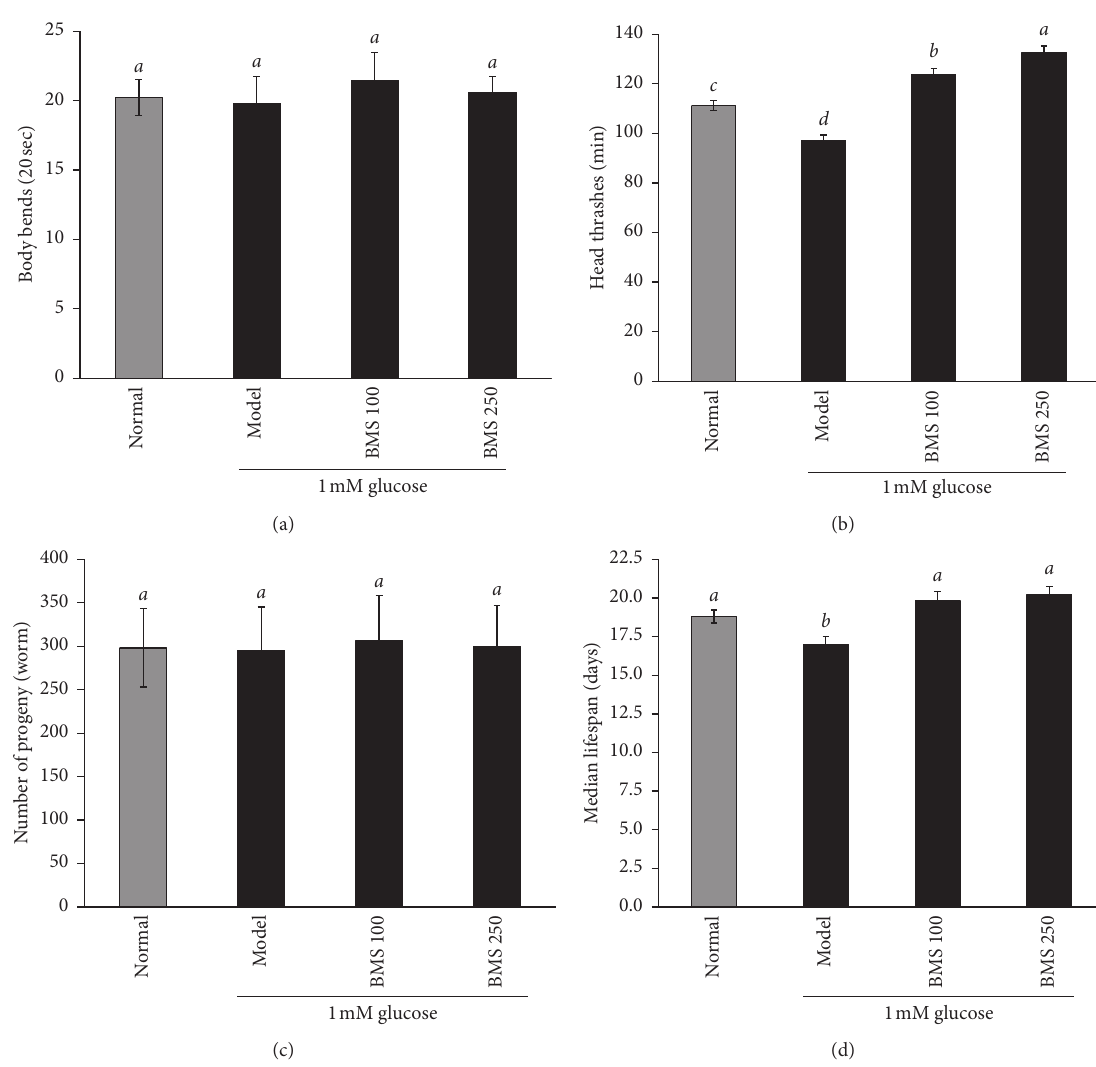
Figure 5: Effects of BMS on the locomotive activity, brood size, and lifespan of glucose-treated C elegans . (a) Body bends, (b) head thrashes, (c) progeny production, (d) median lifespan. Values are expressed as means ± SE. Statistical analysis was performed using ANOVA. Different superscripts were considered significantly different. BMS: bitter melon saponins.